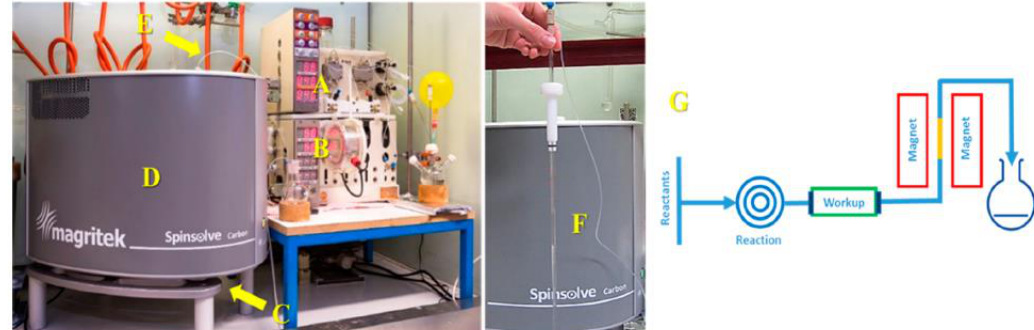
Figure 5. Experimental setup used for process and reaction monitoring and showing a Spinsolve benchtop NMR spectrometer installed for reaction monitoring in a flow system. The middle image shows the glass NMR flow cell, while the right image presents an inline reaction monitoring configuration under continuous flow conditions. Adapted with permission from [66], ACS, 2016.